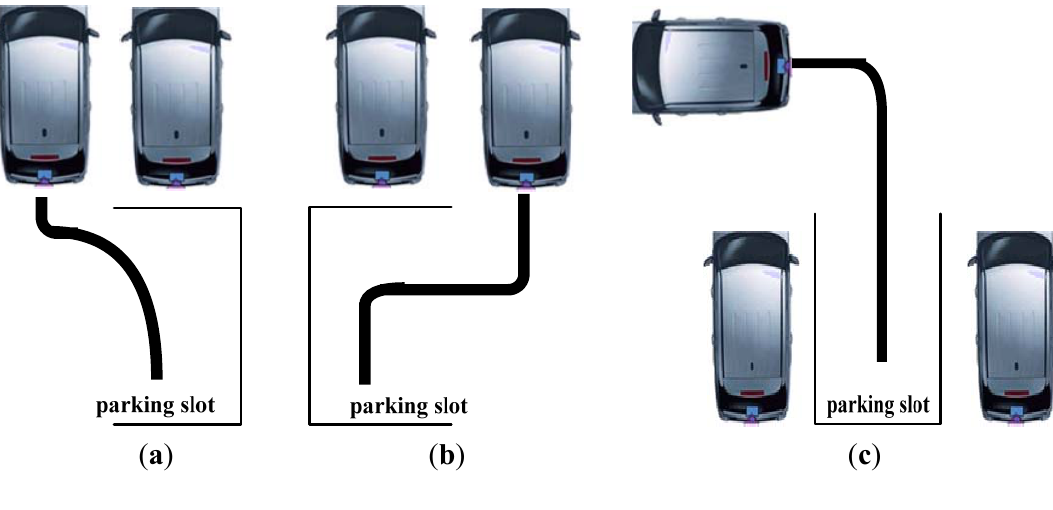
Figure 9. The considered parking cases; (a) Right rear; (b) Left rear; (c)